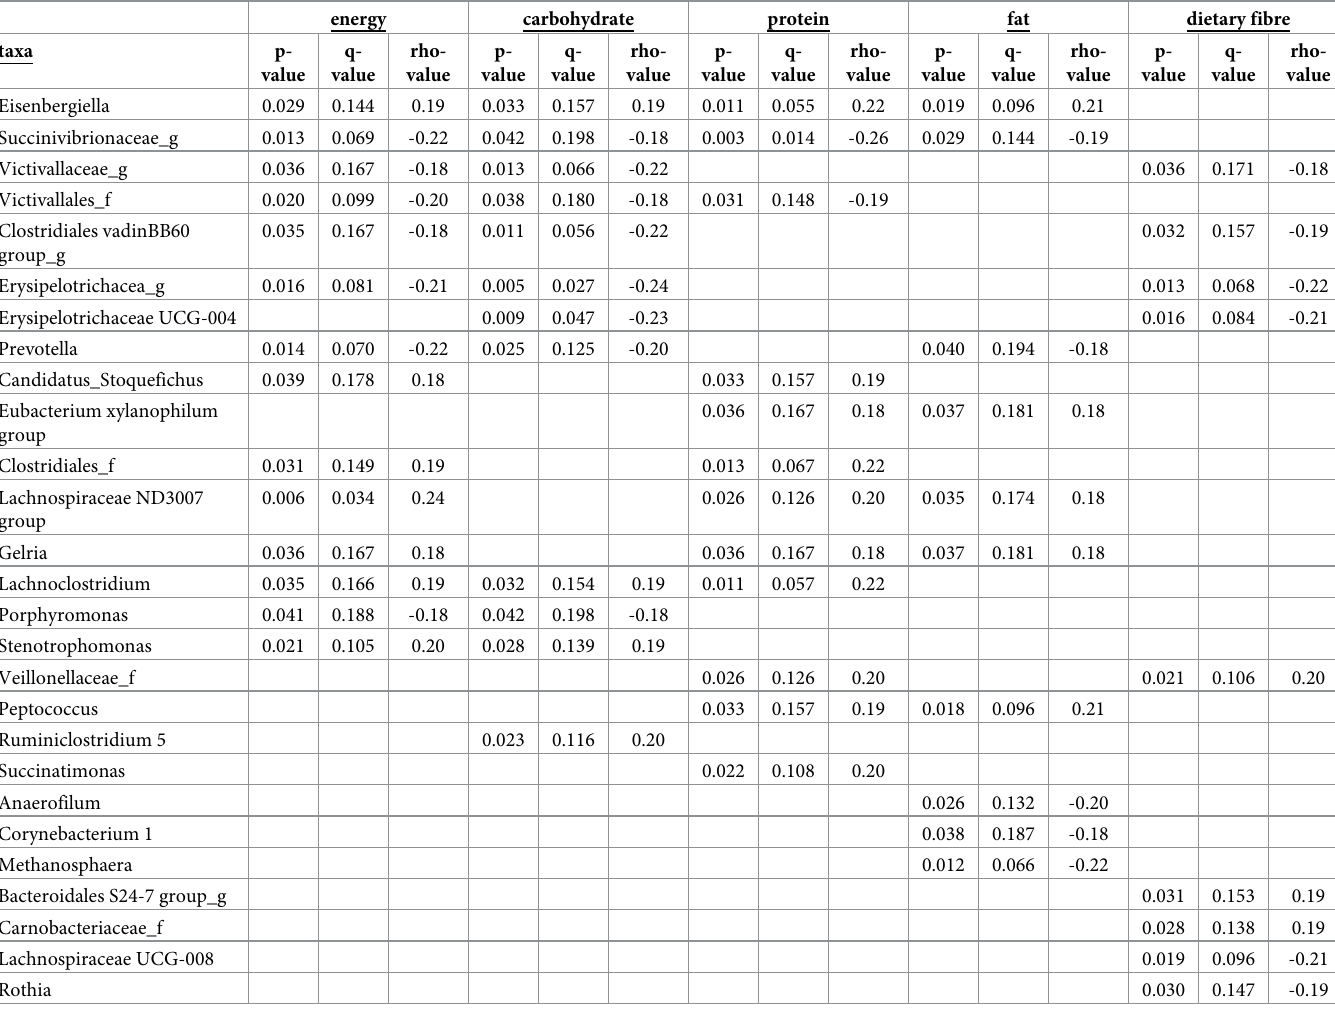
Table 4. Correlation between nutrient and energy intake and microbial taxa. Only taxa that are significant (q < 0.2) are